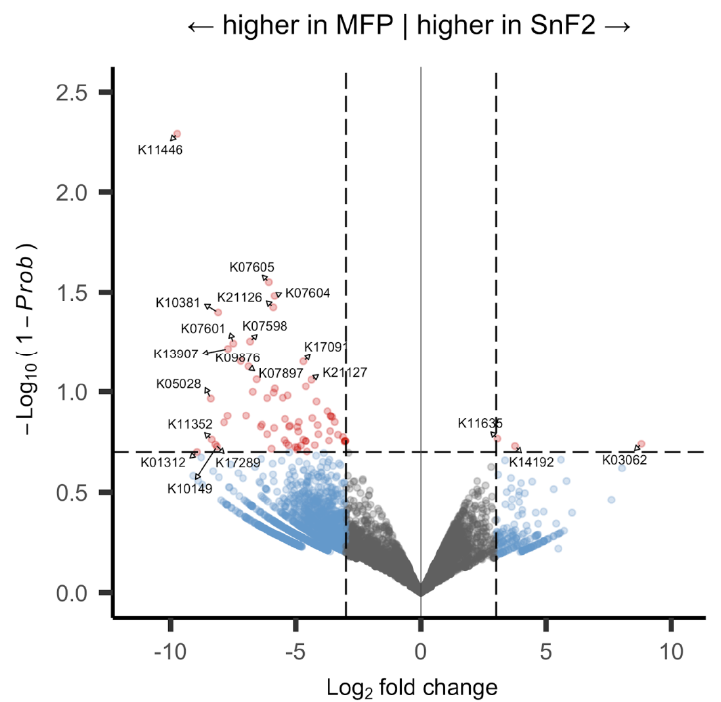
Figure 8. Volcano plot for differential expression of SnF 2 vs. sodium monofluorophosphate (MFP) treatment: points are labeled with KEGG Orthology ( n = 7734), grey pointd are not significant, blue have a log2 fold change greater than 3, yellow have a 1-prob < 0.2, and red have both a high fold change and significant probability; fold change and probability cutoffs are marked with dotted lines.